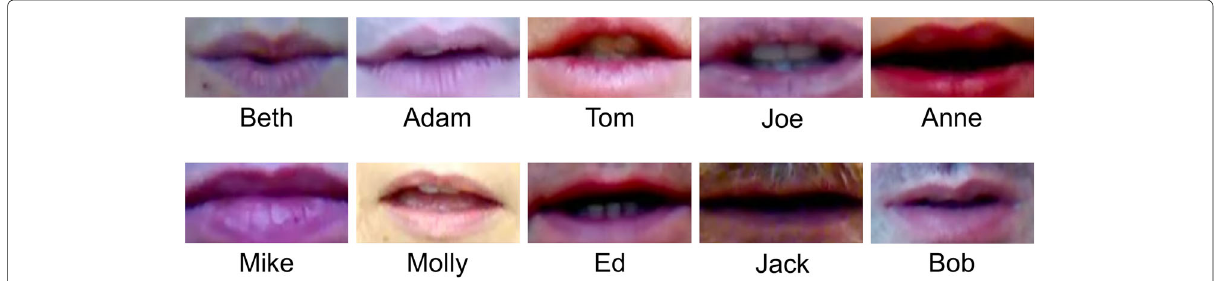
Fig. 9 qFace: sample frames from a 10-digit sequence. The frames were passed to the LipAuth model to obtain the embedding. The figure also highlights the real-world element of this dataset as all videos are considered ‘neutral